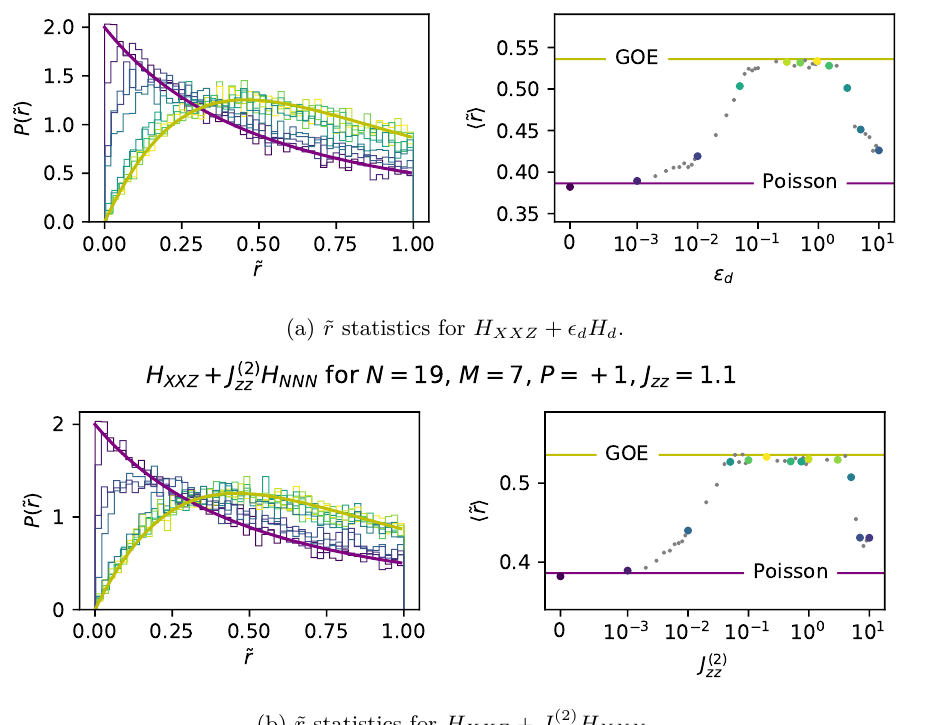
Figure 2. Left: probability distribution functions for the ˜ r statistics of (3.7) (top) and (3.8) (bottom) with increasing value of (cid:15) and J (2) respectively, computed for N = 19 spins in the zz d M = 7 , P = +1 sector with J zz = 1 . 1 . The purple line represents the analytical result for P (˜ r ) in the case of Poissonian level-spacing statistics, while the yellow line represents the analytical result for GOE ensembles. Right: the value of h ˜ r i as a function of (cid:15) (top) and J (2) (bottom). Horizontal zz d lines represent analytical values for Poisson (purple) and GOE (yellow). The colored dots represent point for which we plotted the P (˜ r ) distribution function in the left panel, while the gray dots represent additional data